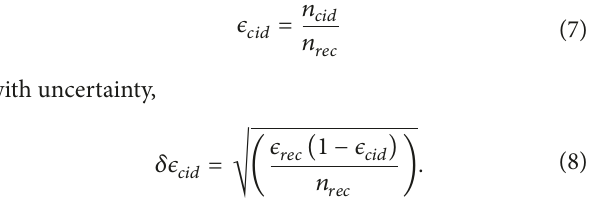
function of input muon momentum for various zenith